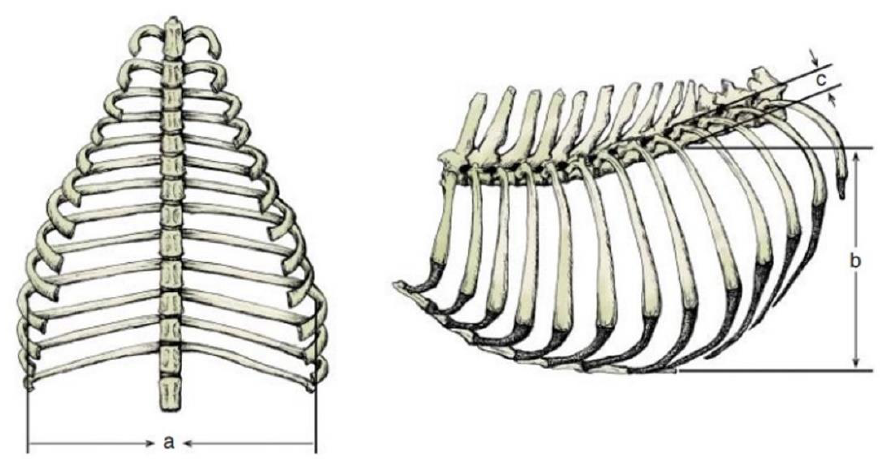
Figure 1. Frontosagittal and vertebral thoracic indices. The frontosagittal index is the ratio between the width of the thorax at the height of the tenth thoracic vertebra ( a ) and the distance between the center of the ventral surface of the tenth thoracic vertebra and the closest point to the sternum ( b ). The vertebral index is the ratio between the distance from the center of the dorsal surface of the selected vertebra to the nearest point of the sternum ( b ) and the dorsoventral diameter of the center of the same vertebra ( c ) (Adamovich-Rippie figure; Culp, 2016